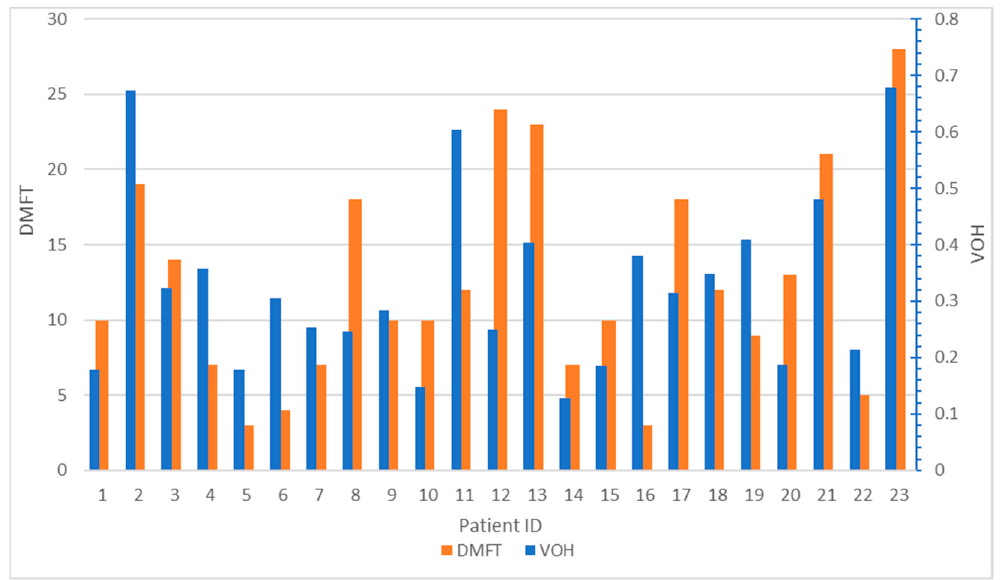
Figure 10. Comparison between VOH (in blue) and DMFT (in orange). From the figure, it is possible to appreciate how the higher the DMFT index, the higher the VOH.